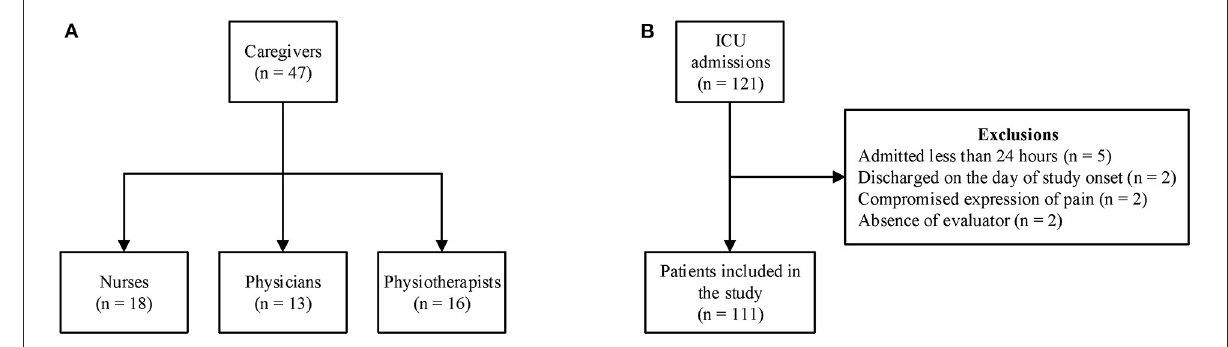
FIGURE1 Flowchart of the study. (A) Distribution of healthcare professionals and (B) patient enrollment.